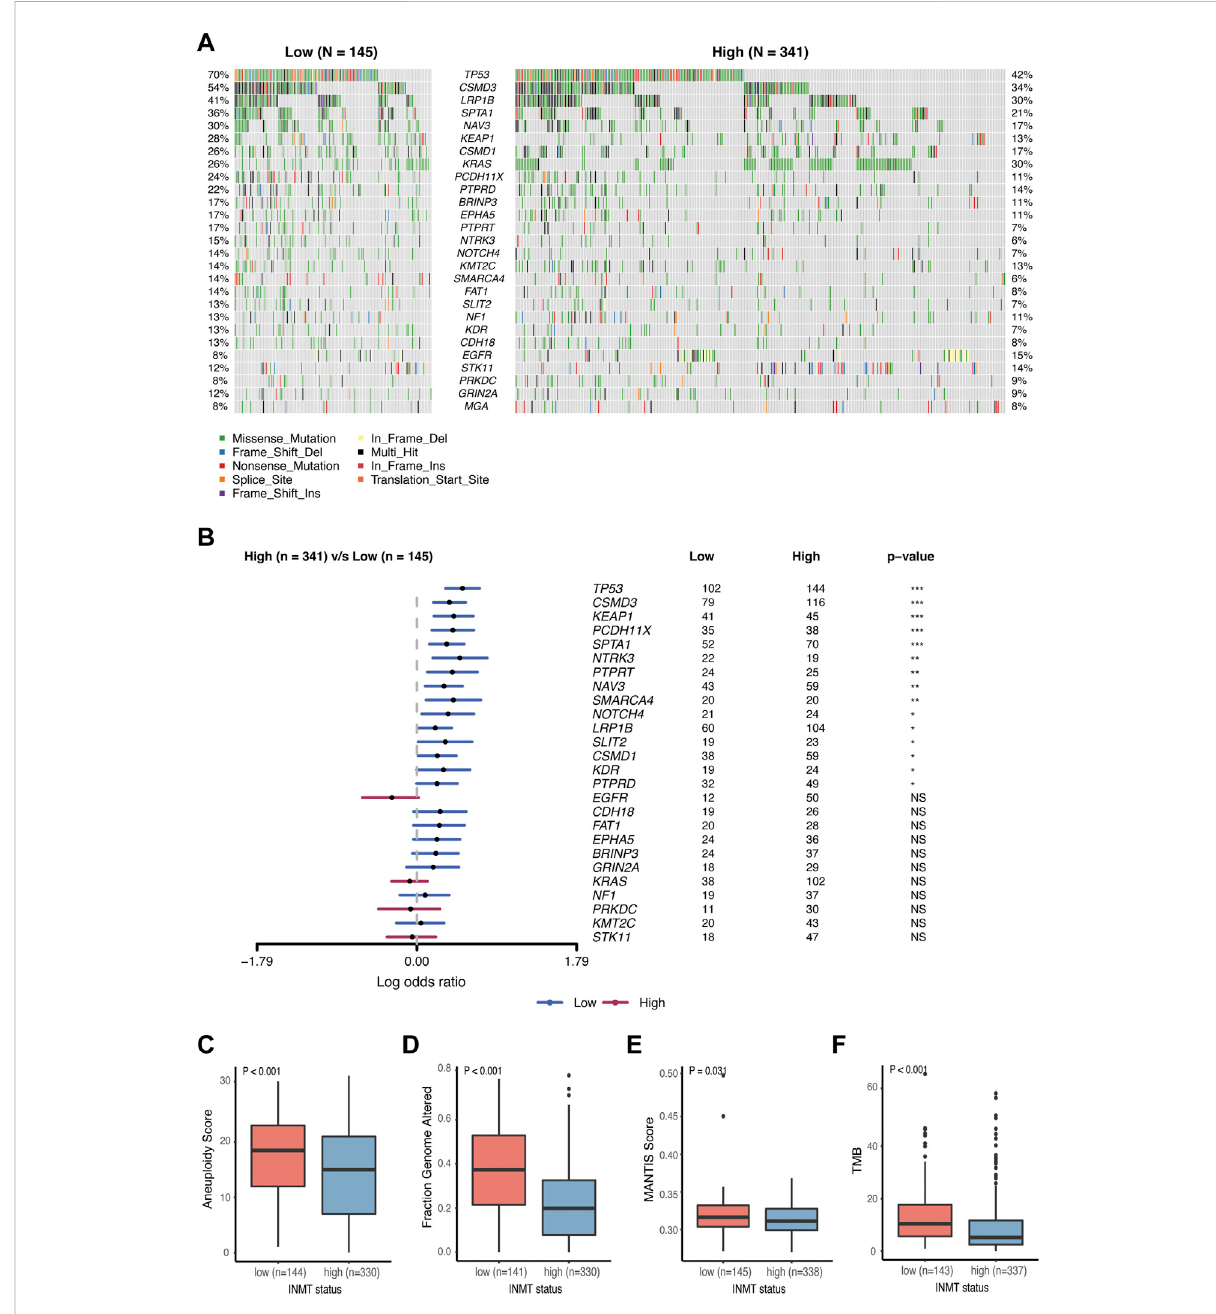
FIGURE 7 Association between INMT and gene alterations in TCGA-LUAD cohort. (A) Common tumor-related gene mutation information illustrated in the somatic mutation spectrum in low- and high-INMT groups, respectively. The genes in the top 20 of the population mutation frequency are shown in the fi gure. (B) Forest plot examined the difference in the population frequency of mutant genes between the high- and low-INMT groups. (C – F) Distribution of the aneuploidy score (C) , a fraction of genome altered score (D) , MANTIS score (E) , and TMB score (F) between low- and high-INMT groups. TMB, tumor mutation